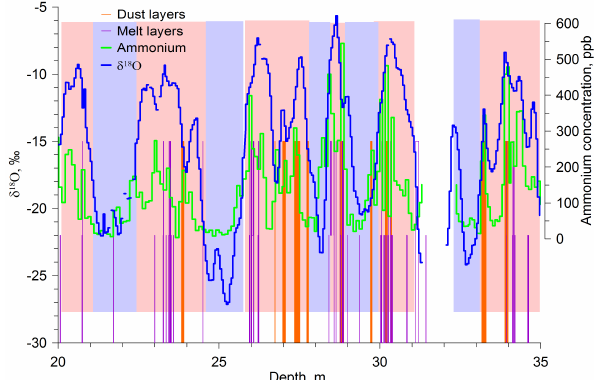
Figure 3. Illustration of the scheme used to identify warm and cold half-years (respectively indicated by the light red and light blue shaded areas) based on the deviation of the mean δ 18 O values from the long-term average value. The purple lines depict the melt layers observed in the core; dust layers are shown in orange, and the am- monium concentration graph (Mikhalenko et al., 2015) is in